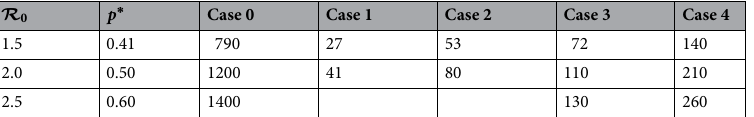
Table 1 summarizes the basic parameters n , θ , and φ for the active group with different choices of a ∗ . Case 0 is the uncontrolled scenario without any protection or dynamic control measures. Cases 1, 2, 3, and 4 correspond to the proposed control schemes with a ∗ = 50 , 55, 60, and 65. As observed, both the IHR θ and IFR φ increases with a ∗ . Both IHR and IFR are substantially lower for Cases 1 to 4 than for Case 0 (no protection). Below, we examine the social acceptability and feasibility conditions using the baseline parameters shown in the table. Social acceptability.